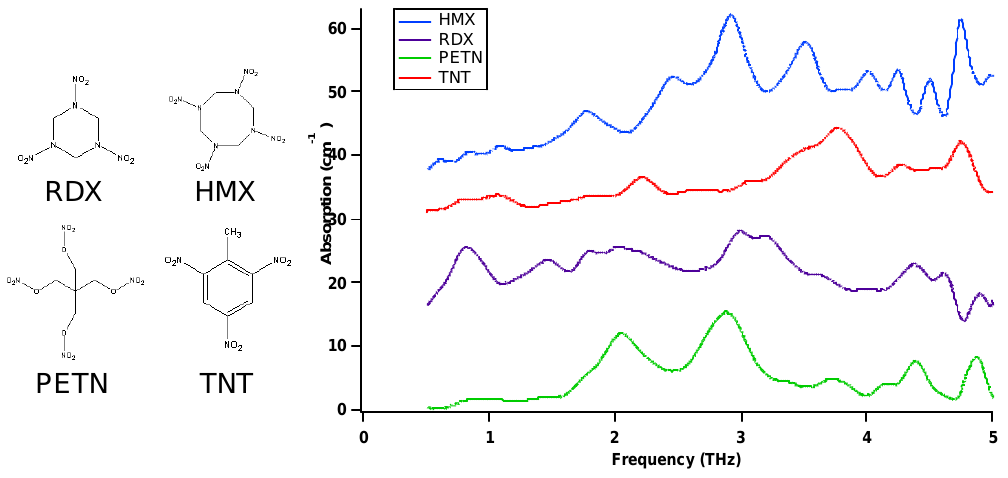
Figure 16. [Left] Chemical structure of the explosives RDX (1,3,5-trinitroperhydro-1,3, 5-triazine), HMX (1,3,5,7-tetranitroperhydro-1,3,5,7-tetrazocine), PETN (pentaerythritol tetranitrate), and TNT (2,4,6-trinitrotoluene). [Right] THz time-domain spectra of four explosives in polyethylene powder pellets. Data adapted from